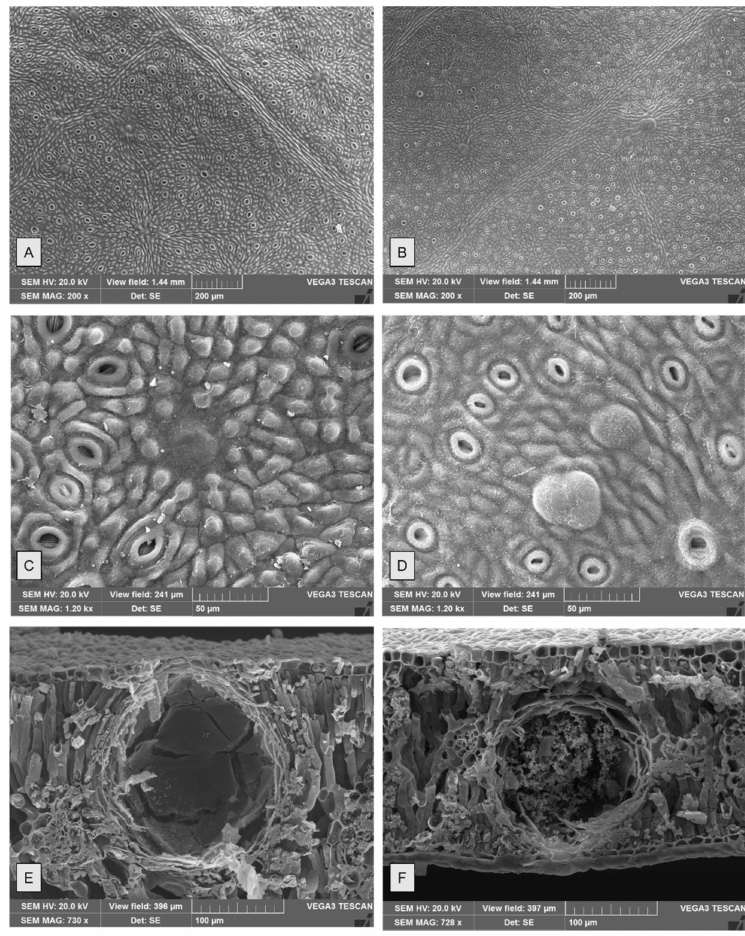
Figure 4. SEM—Comparison between E. gunnii ( A , C , E ) and E. pulverulenta ‘Baby blue’ ( B , D , F ) leaves. Adaxial surfaces at 200 × ( A , B ). Overlying cells surrounding oil cavities in the abaxial surfaces, at 1200 × ( C , D ). Leaf transversal sections showing oil cavities, containing amorphous material ( E , F ).